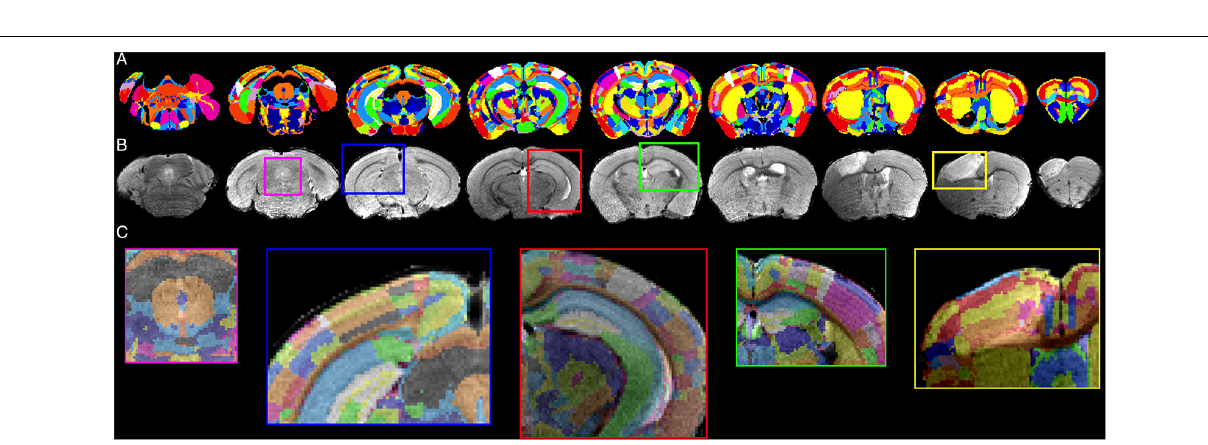
Frontiers in Neuroinformatics | www.frontiersin.org